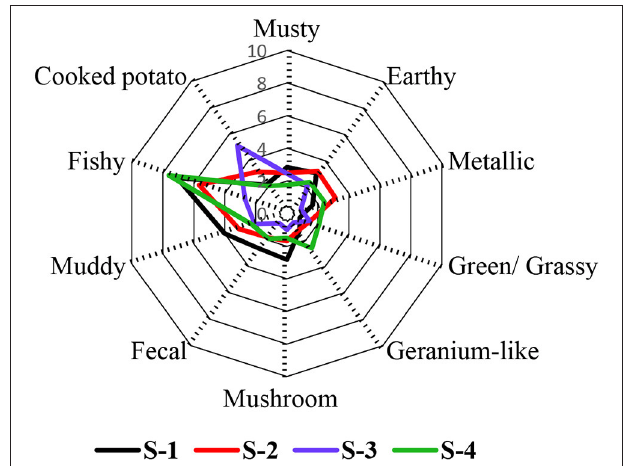
FIGURE 1 | Odor sensory profile analysis of four commercial fish feeds. The data are displayed as mean values of the ortho-nasal sensory evaluation of three independent replicates (13 panelists).